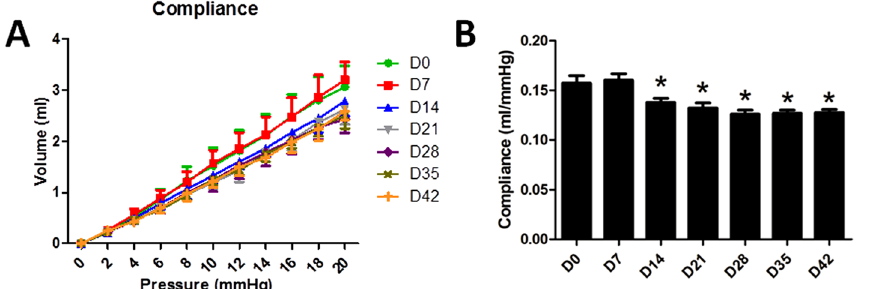
Figure 3. Alterations of rectal compliance in DSS-induced colitis rats. ( A ) The pressure–volume curves from the sequential isobaric distensions at different time points. ( B ) Rectal compliance at different time points. * P < 0.05 compared with Day 0. (N =